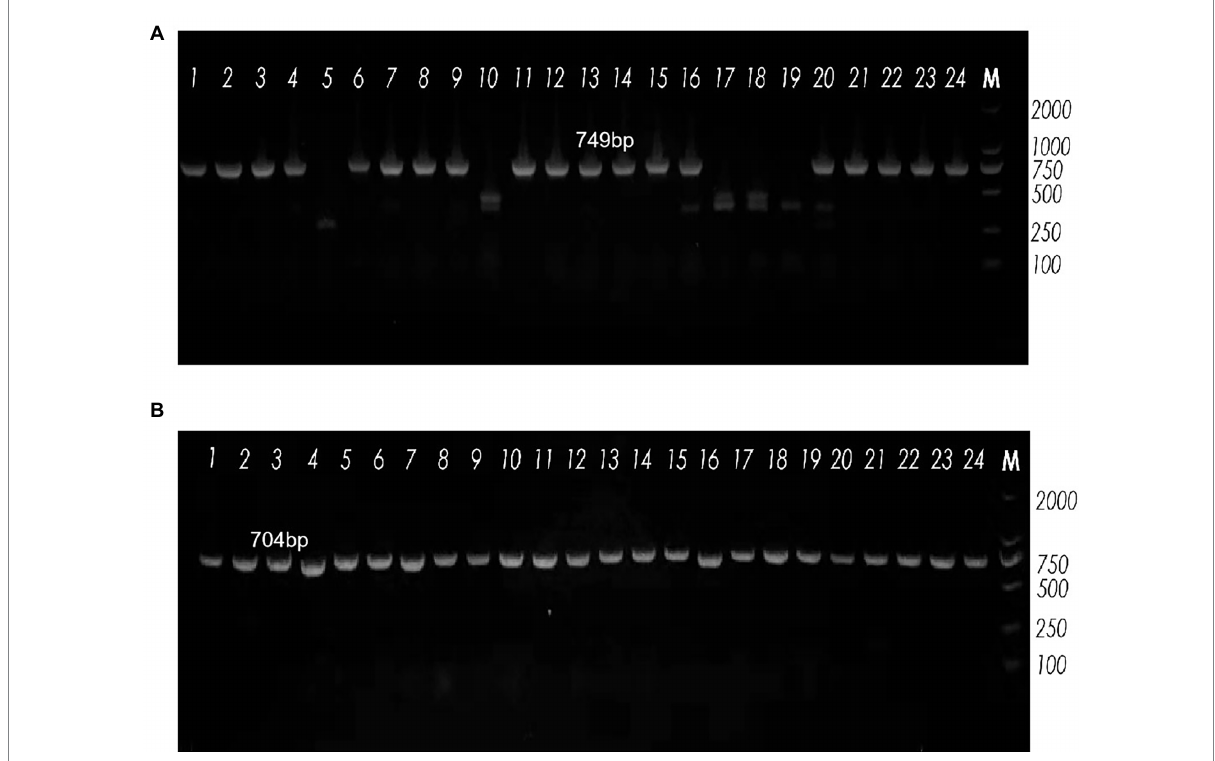
FIGURE 3 Agarose gel electrophoresis showing band patterns. (A) The expression levels of the vly gene, as demonstrated by agarose gel electrophoresis. Lane M: DNA marker (DL2000); Lanes 5, 10, 17, 18 and 19: DNA samples negative for the vly gene; Lanes 1 − 4, 6 − 9, 11 − 16, 20–24: DNA samples positive for the vly gene. (B) The expression levels of the sialidase A gene, as detected by agarose gel electrophoresis. Lane M: DNA marker (DL2000); all lanes were positive for the sialidase A